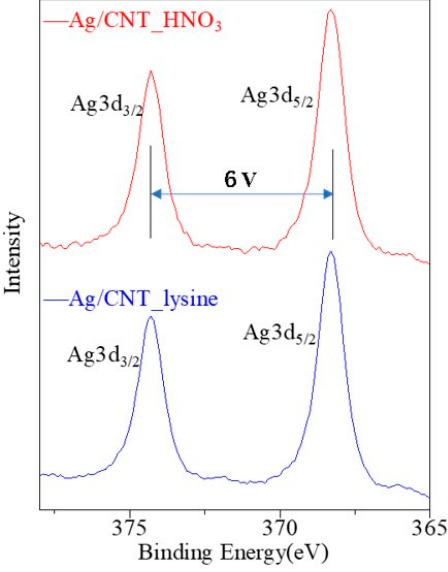
Figure 6. High ‐ resolution XPS survey spectrum of the Ag3d peak. Figure 6. High-resolution XPS survey spectrum of the Ag3d peak.